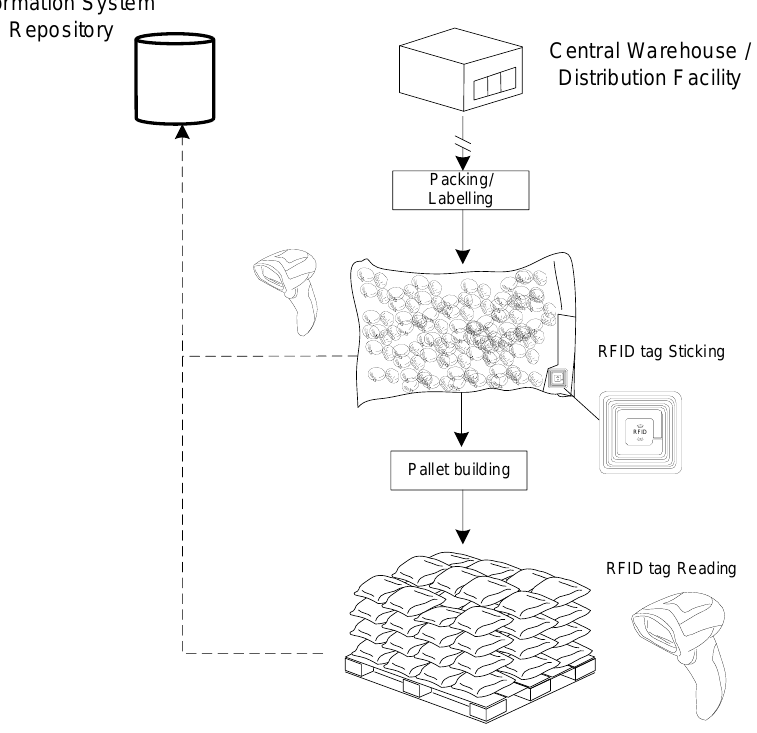
Figure 3. Central warehouse operations.